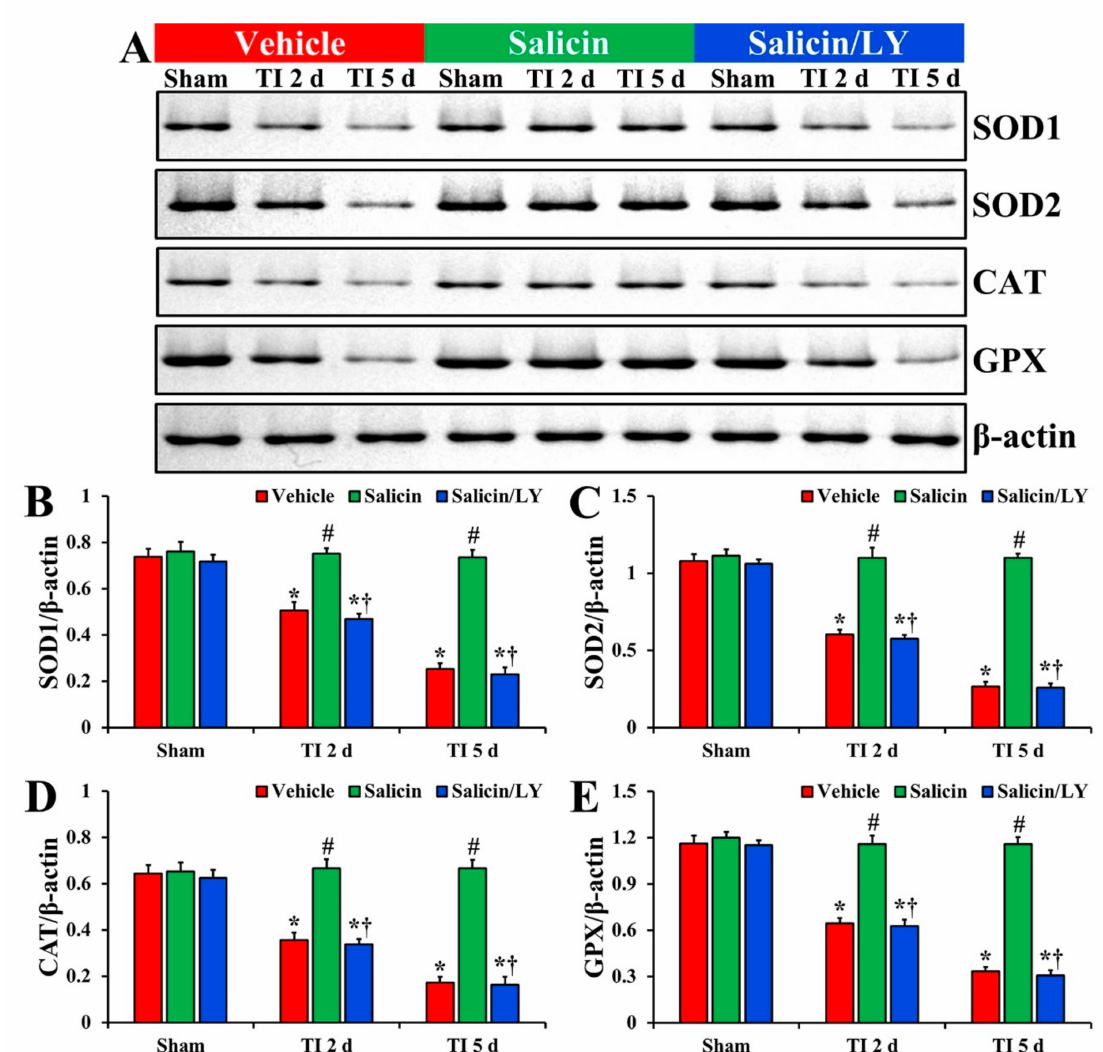
Figure 7. ( A ) Western blot images of SOD1, SOD2, CAT, and GPX in CA1 of the vehicle-treated, salicin-treated, and salicin/LY-treated groups at sham, 2 days, and 5 days after TI. In the salicin-TI group, each SOD1, SOD2, CAT, and GPX level is significantly higher than that in the vehicle-TI group. While in the salicin/LY-TI group, each SOD1, SOD2, CAT, and GPX level is similar to that in the vehicle-TI group. ( B – E ) Quantitative analyses of SOD1 ( B ), SOD2 ( C ), CAT ( D ), and GPX ( E ) level by normalization to the level of β -actin, respectively. The bars indicate the means ± SEM ( n = 5 at each time, * p < 0.05 vs. each sham group, # p < 0.05 vs. vehicle-TI group, † p < 0.05 vs. salicin-TI group; the vehicle-sham group was regarded as control